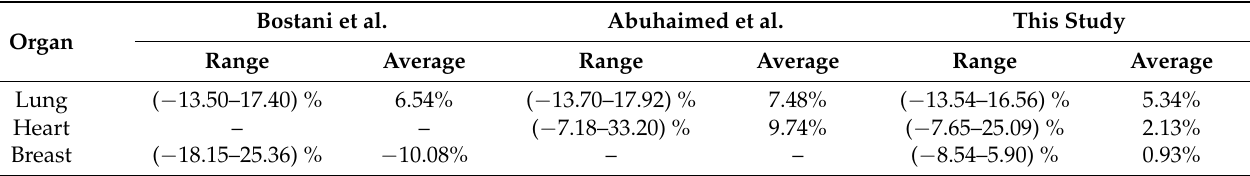
Based on the above functions, the relative deviations between the estimated organ doses and the simulated ones for the 18 patients are summarized in Table 2. For compari- son, the deviations estimated by using the functions built by Abuhaimed et al. [17] and Bostani et al. [15] are also listed in Table 2. The organ doses for comparison in the table from Bostani et al. were calculated using the regional average WED . Table 2. Relative deviations* between the estimated organ doses and the simulation results for the 18 patients. Bostani et al. Abuhaimed et al. This Study Organ Range Average Range Average Range Average Lung Heart Breast * Relative deviations = (MC simulation results − estimated organ doses)/MC simulation results × As shown in Table 2, for lung, heart, and breast doses, the average deviation of all 18 patients was less than 10.08% when using any of the three functions. It indicates that the function built by Bostani et al. and Abuhaimed et al. using patients from a Western pop-